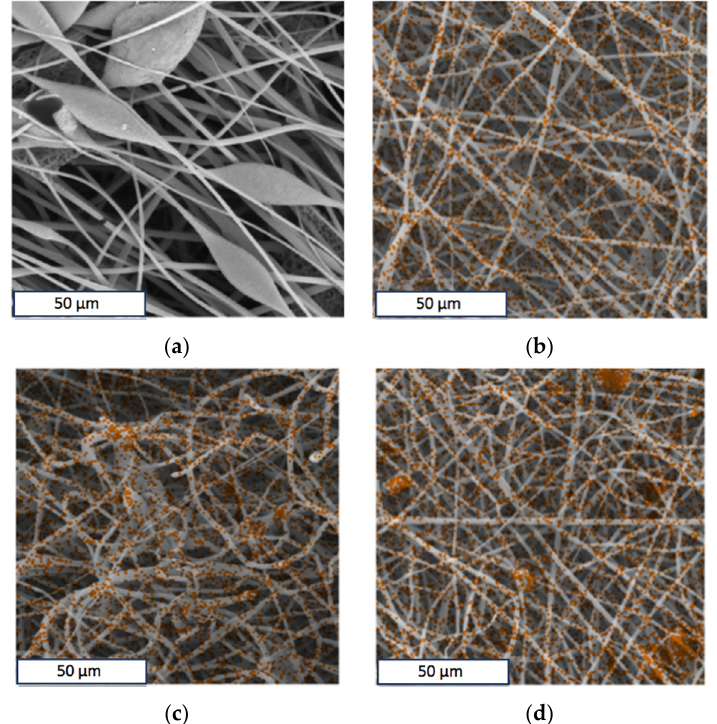
Figure 4. The energy-dispersive X-ray spectroscopy elemental analysis of Fe in the PHB with different content of hemin: 0 ( a ), 1 ( b ), 3 ( c ) and 5 ( d) wt. %.